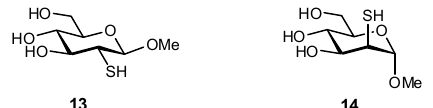
Figure 4. 2-Thiocarbohydrates were evaluated as ligands of the plant lectin ConA [126].